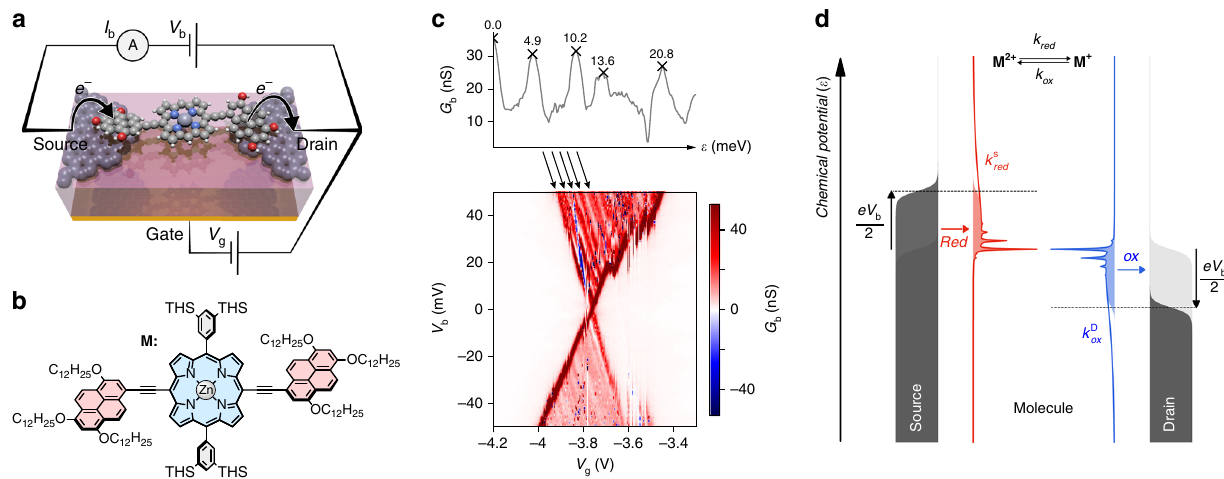
Fig. 1 Charge-transport characteristics of a graphene-porphyrin single-molecule junction. a Schematic representation of our device architecture: nanometre-separated graphene source and drain electrodes are used to contact the molecule, and a local gate electrode separated from the molecule by a thin layer of HfO 2 (10 nm thick) is used to shift the molecular energy levels. For clarity, the bulky side-groups are not shown. b The molecule M used in this study comprises of a porphyrin core (blue), with solubilising aryl side-groups on two of the porphyrin meso -positions (grey), and π -stacking anchor groups on the other two meso -positions (red); here THS is trihexylsilyl. c Charge stability diagram showing the differential conductance ( G b ) as a function of bias voltage ( V b ) and gate voltage ( V g ) at 3.5 K; the actual gate voltage experienced by the molecule is only a fraction of the applied gate voltage because of the drop across the HfO 2 layer. The top panel shows the differential conductance of the top triangle as an average along the lines indicated by the arrows running parallel to the edge of the triangle. d Schematic representation of current fl owing through our single-molecule transistor. The molecular DOS for reduction and oxidation processes are shown in red and blue, respectively, with electron-transfer rates shown as coloured areas. The Fermi-Dirac distributions f S and f D , are shown as the grey areas for source and drain, respectively. At negative bias voltage, electrons tunnel sequentially from the source via the molecule into the drain. For convenience, the bias voltage is drawn as applied symmetrically across the source and drain